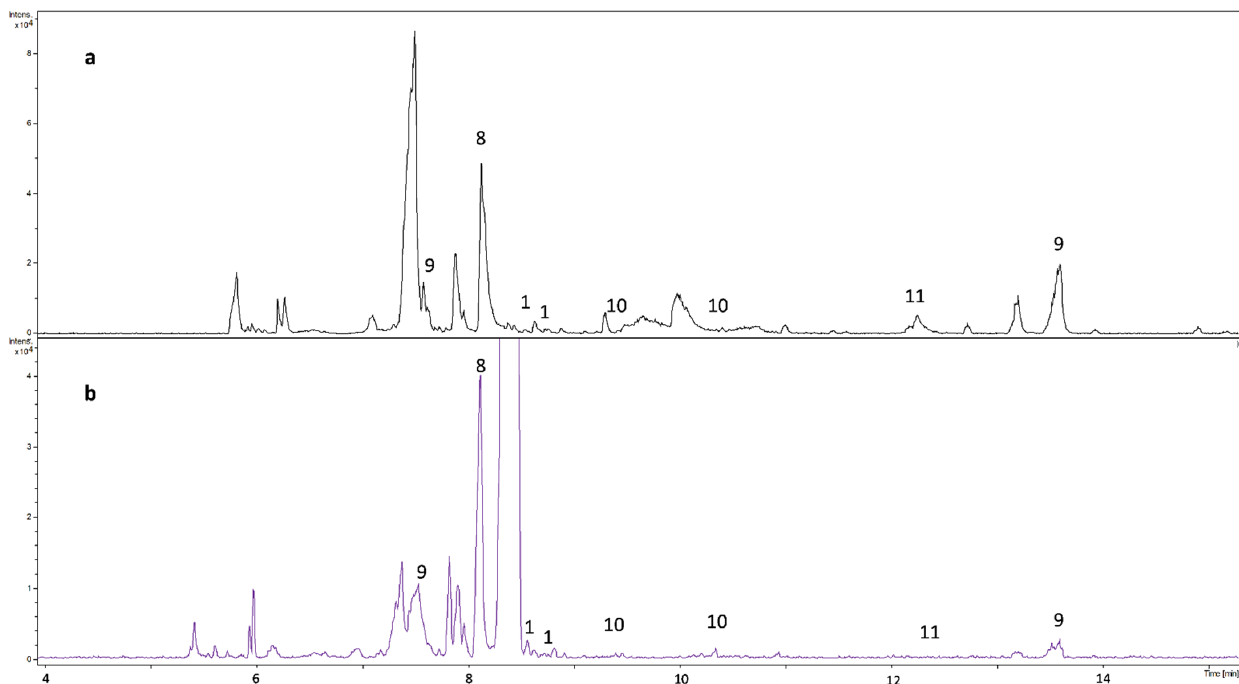
Figure 4. Base peak CZE-MS electropherograms obtained for two different SPE extracts of the same honey sample (sunflower). Conditions are the same as in Figure 2a. The number of the peaks correspond with the number assigned to the components given in Figure 1. SPE (Dionex OnGuard RP cartridge) for ( a ): preconditioning the cartridge with 9 mL MeOH, 9 mL water and 9 mL 10 mM